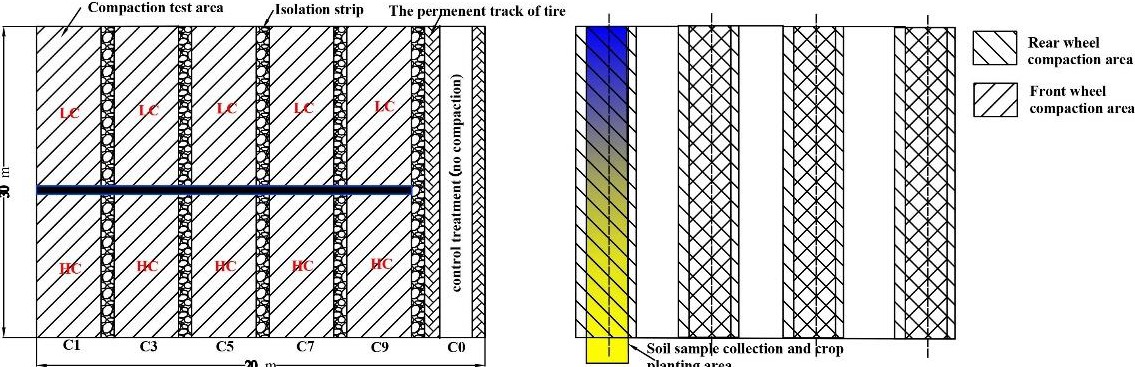
Figure 1. Field-experiment-specific operation method. LC—tractor with low mass, John Deer 280; HC—tractor with high mass, LOVOLM904; C1, C3, C5, C7, and C9 represent the number of tractor passes, respectively, C0 was the no-compaction treatment. Table 2. Test tractor tire parameters.